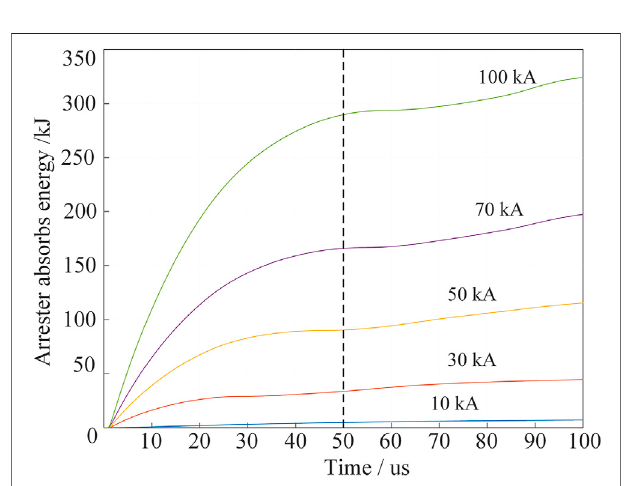
FIGURE 8 | Comparison diagram of absorbed energy of #1 tower line arrester under different lightning current amplitude intrusion.